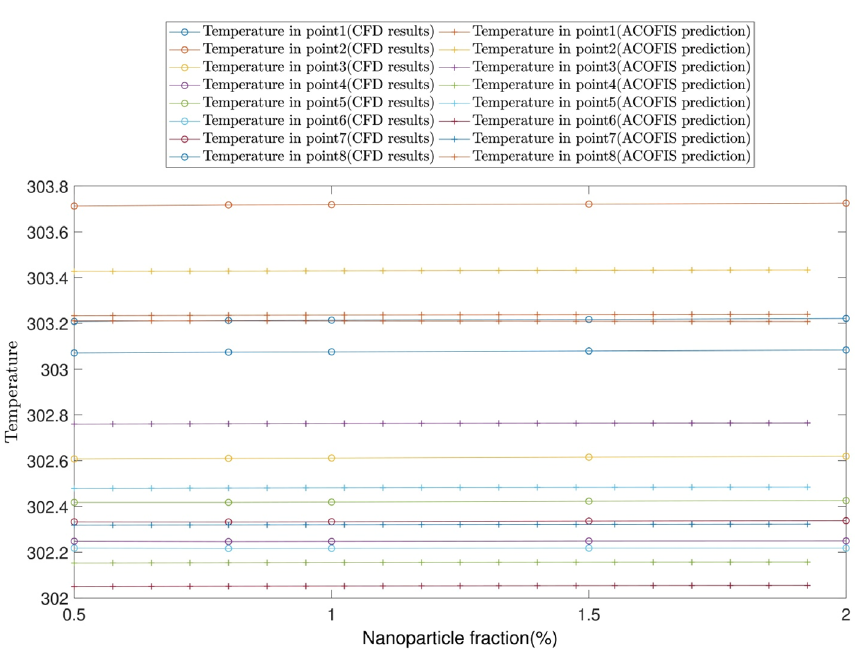
Figure 13. Pattern of predicted temperature in different nanoparticle